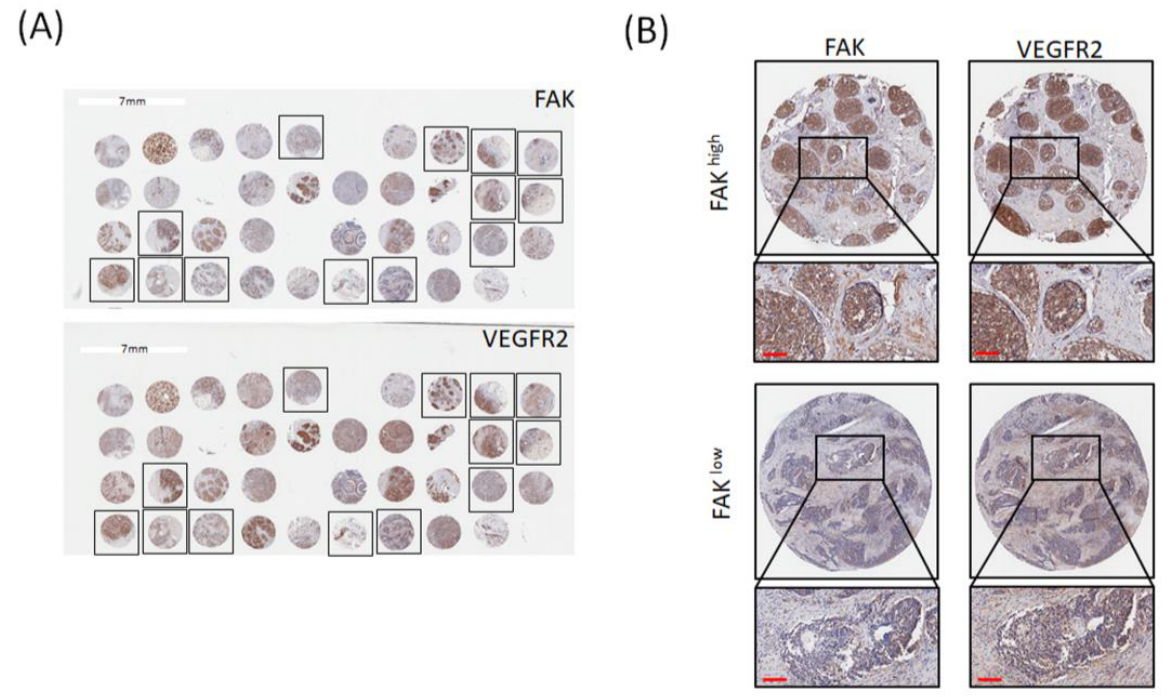
Figure 2. FAK protein expression is correlated with VEGFR2 expression. ( A ) Representative IHC staining results for expression of FAK and VEGFR2 in breast cancer tissue microarrays. ( B ) Immunoreactivity of FAK and VEGFR2 was classified as high expression ( upper ) and low expression ( lower ) based on staining observed for the cell cytoplasm and membrane. (Scale bar: 100 μm). Table 1. Association of FAK and VEGFR2 expressions in all breast cancer tissues, non-TNBC tissues and TNBC tissues.